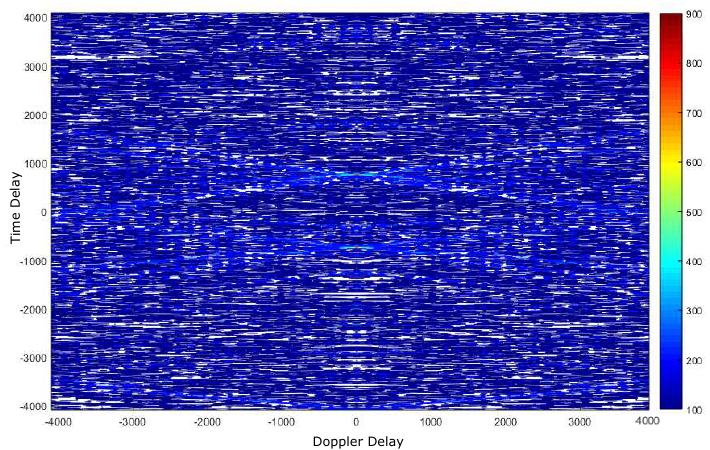
Figure 23. Two closer scatterers using chirp pulses (MMPP): 2D, at − 5 dB SNR.